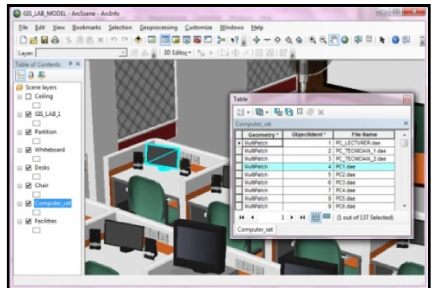
Figure 14. The 3D model filename existed in the attribute